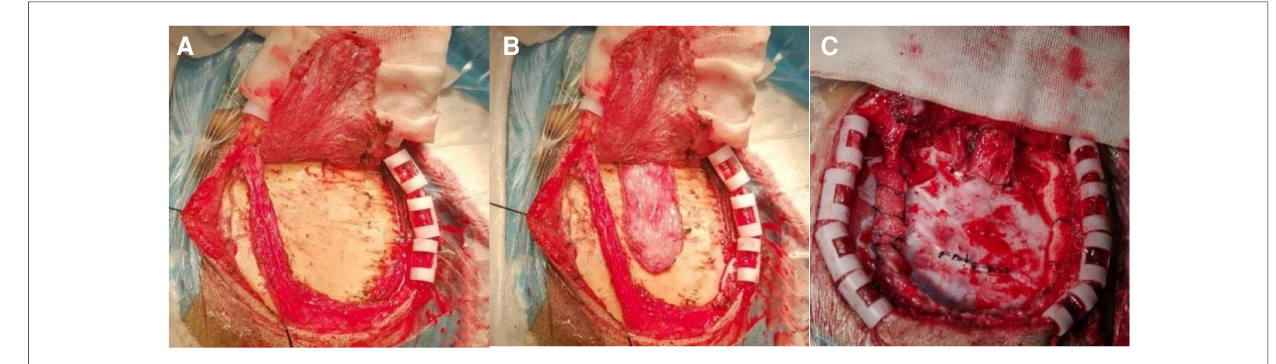
FIGURE 1 Intraoperative image of a typical patient. ( A ) Free super fi cial temporal artery with a little fascia; ( B ) dissociating the super fi cial temporal fascia above the temporalis; ( C ) the super fi cial temporal fascia was sutured to the dura by crossing under the dural bridge, and the temporal cut dura was turned over and applied to the brain surface.